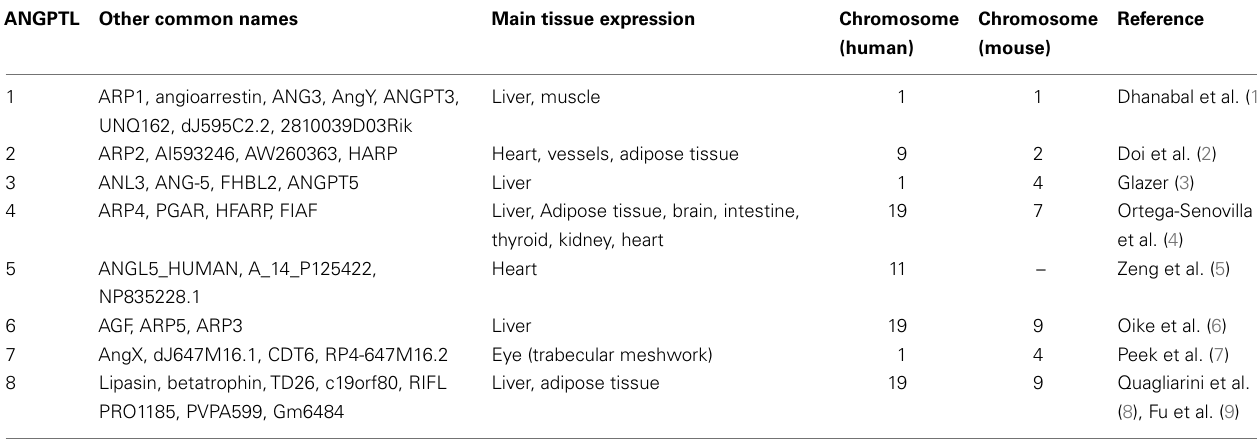
Table 1 |Angiopoietin-like proteins